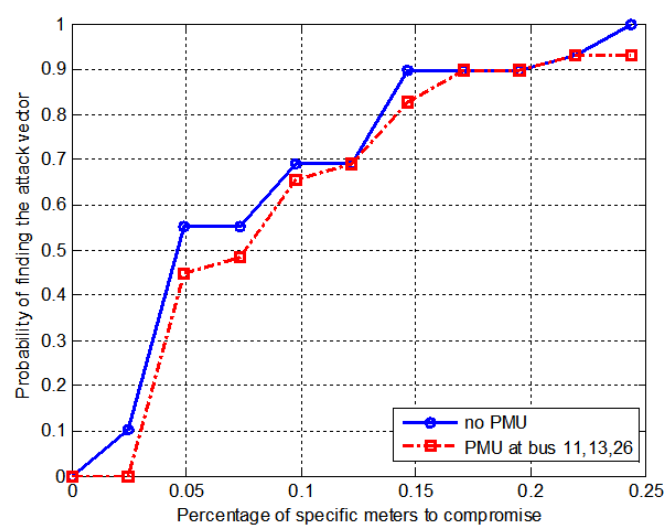
Figure 5. IEEE 30-bus system.